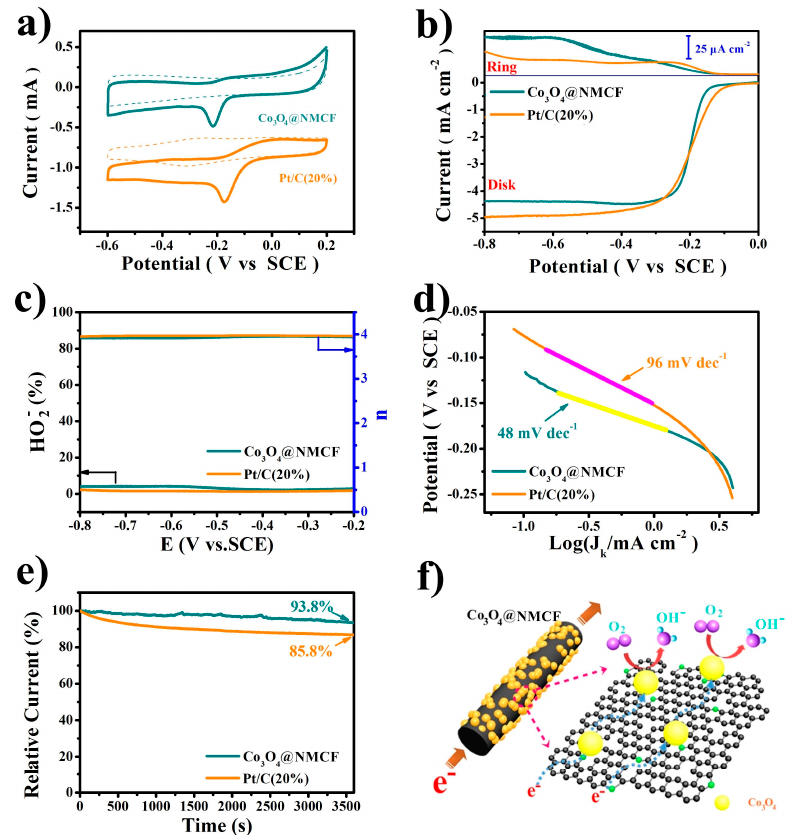
Figure 4. ( a ) CV curves (dash line: N 2 ; solid line: O 2 ), ( b ) RRDE voltammograms at 1600 rpm, ( c ) OH 2 − yield and corresponding electron transfer number, ( d ) the Tafel slope, ( e )